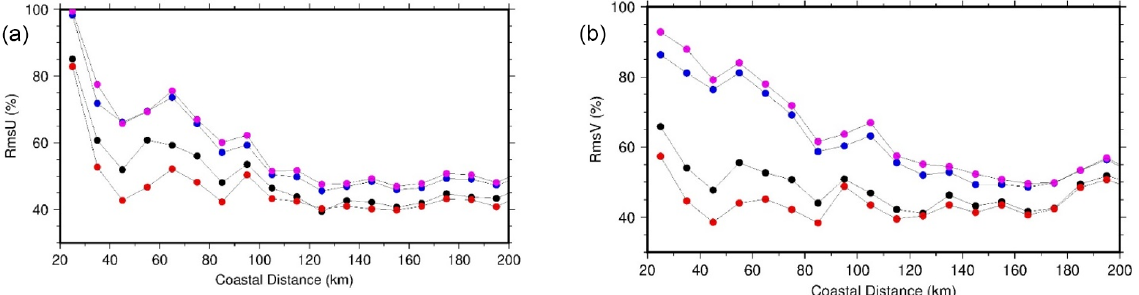
Figure 21. Zonal (a) and meridional (b) RMS differences as a function of coastal distance between the independent drifting buoy velocities and the altimeter geostrophic velocities obtained using different MDT solutions – pink: the CNES-CLS13 MDT first guess; blue: the CNES- CLS18 MDT first guess; black: the CNES-CLS13 MDT; and red: the CNES-CLS18